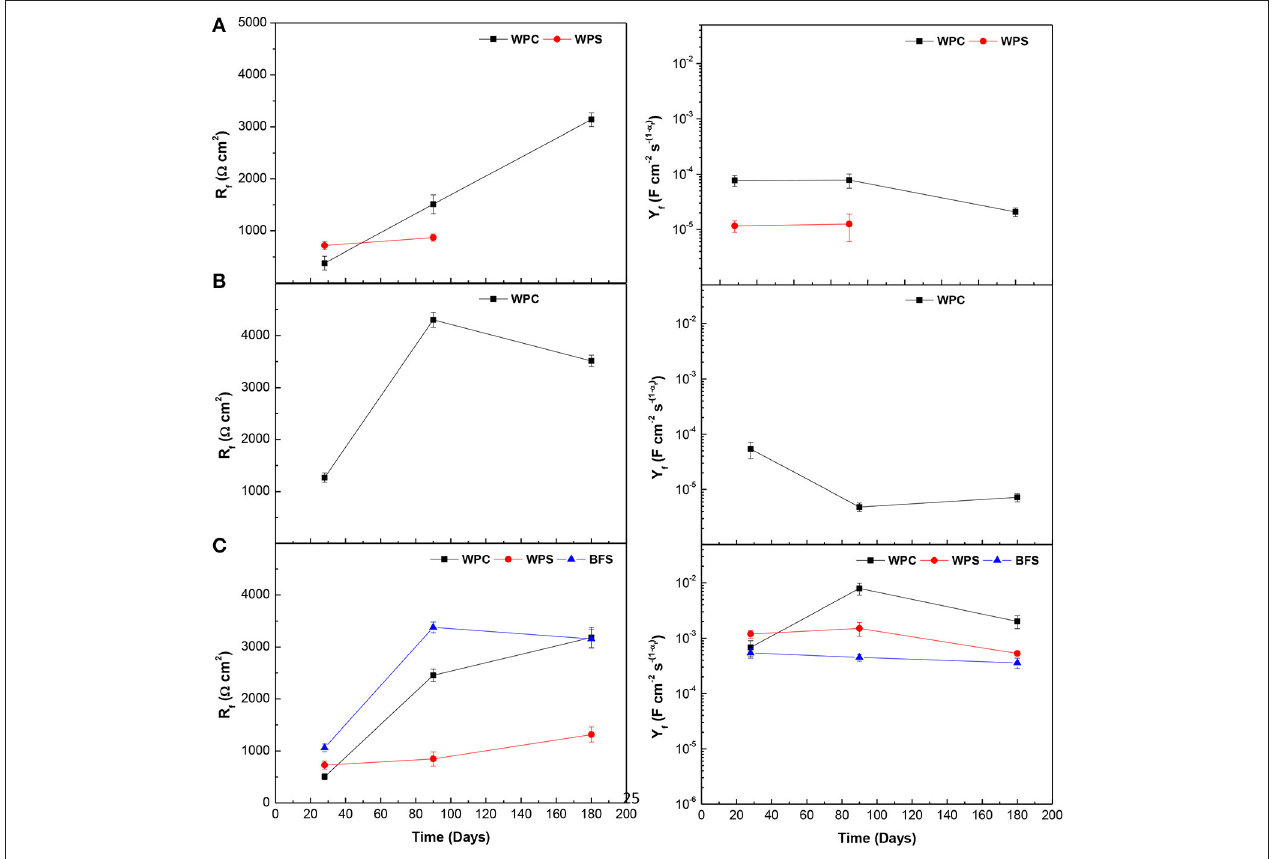
FIGURE 10 | Comparison of dielectric properties of rust layer/passive film layer resistance R f , and capacitance Y f , for the three types of specimens under different environments: (A) alkaline solution, (B) water, and (C) standard laboratory